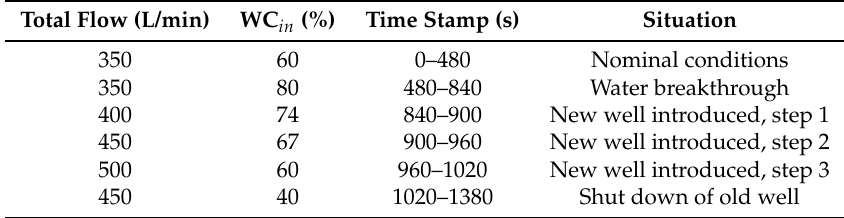
Table 7. Inlet conditions used in all experiments.